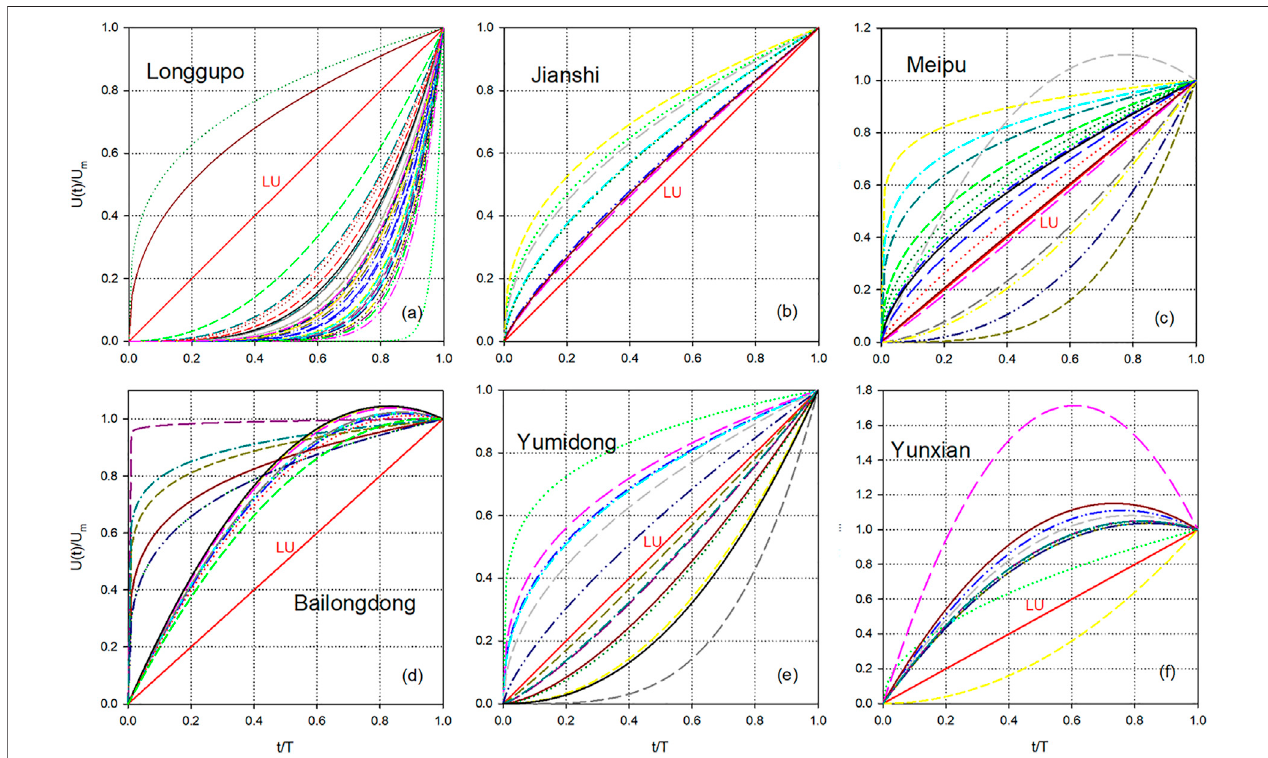
FIGURE 3 | Uranium migration process of the dated fossil samples by the ESR/U-series method from six sites in the Three Gorges region reconstructed by US ( p -value)orAUmodel( n -value)(theU-uptakehistoryofbothenamelanddentinetissuesofeachsamplefromthesitewerepresentinthesame fi gurewithdifferentcolors.